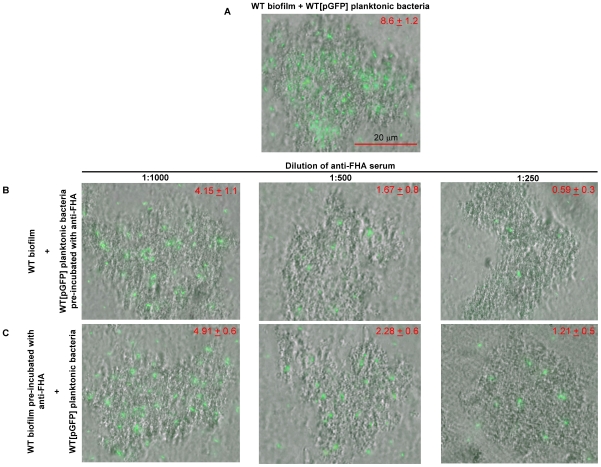
Inhibition of association of B. pertussis planktonic cells with the biofilms by anti-FHA serum.GFP-tagged planktonic bacteria of the WT (BPSM) strain, pre-incubated with SS medium (A) or with (B) dilutions of anti-FHA serum, followed by incubation for 4 h with 24-h-old WT biofilms. (C) Twenty four-h-old WT biofilms pre-incubated with dilutions of anti-FHA serum, and then subjected to a 4-h incubation period with planktonic GFP-tagged WT bacteria. GFP-expressing bacteria attached to the biofilms were visualized by acquiring multi-channel (transmitted light and fluorescence) CLSM images. At least six microscopic fields per coverslips and four coverslips per condition were analysed. A representative merged image for each condition is shown. The data indicated in the top right of each image are the means ± standard deviations of the numbers of GFP-tagged bacteria per 100 µm2 of pre-formed biofilm microcolony derived from the analysis of twenty four microscopic fields on four coverslips per condition. The numbers of attached bacteria was determined by examining multi-channel images using ImageJ in conjunction with the ITCN plug-in.